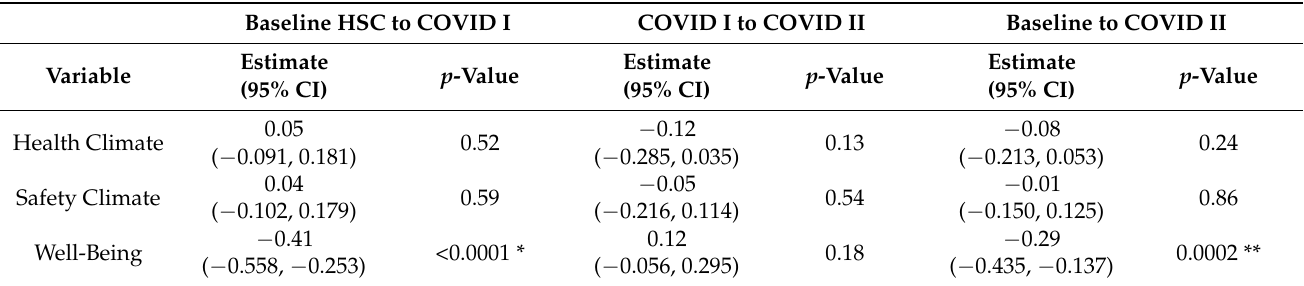
Figure 2. Least squares mean estimation of health climate, safety climate, and employee well-being at each timepoint. Table 3. Mixed-effects linear regression analyses showing change in health climate, safety climate and well-being scores at Table 3 presents the change in outcomes across the three timepoints, for the two in- three survey occasions, N = tervention groups combined. Health climate and safety climate remained stable across the three timepoints. However, well-being scores declined between the baseline HSC survey